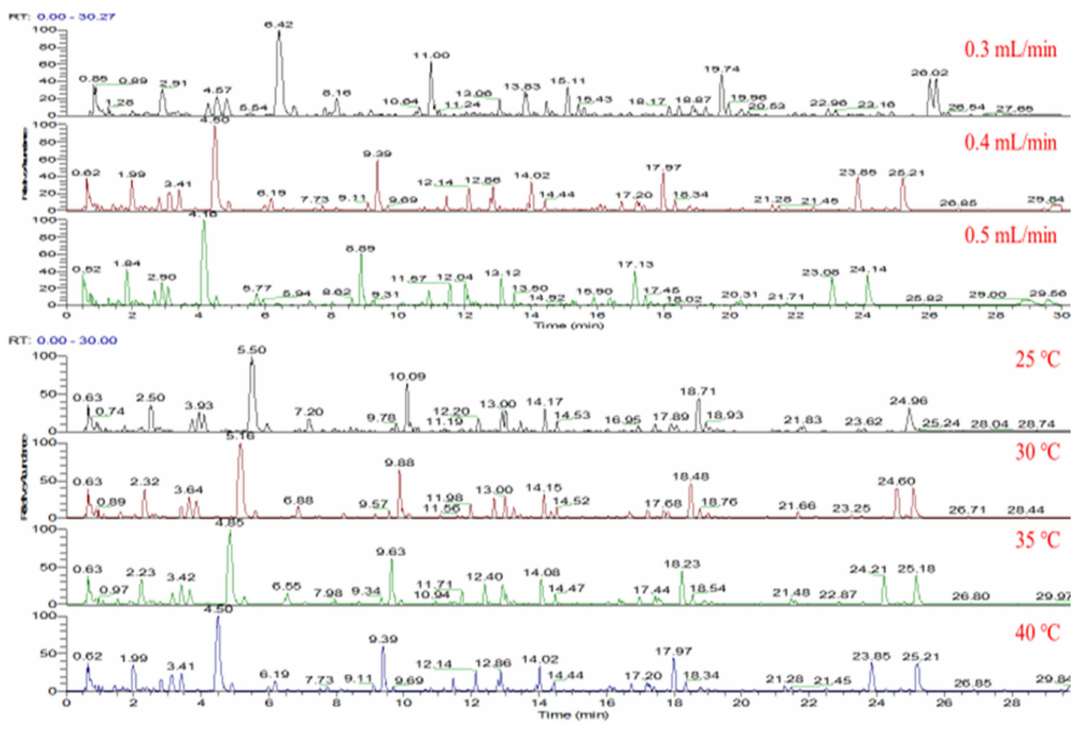
Figure 1. The typical Base Peak ion (BPI) of Gentianae Radix et Rhizome (GRR) chromatographic separation.